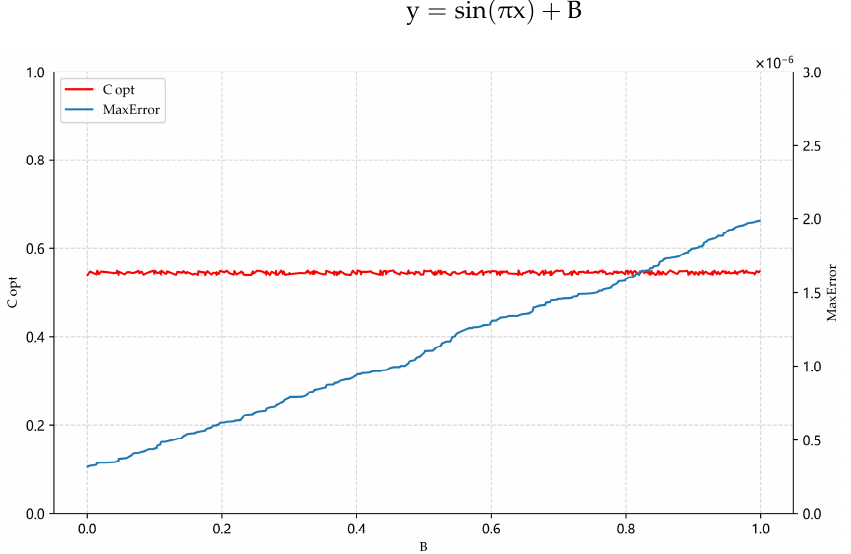
Figure 4. In fl uence of B on interpolation. Figure 4. Influence of B on